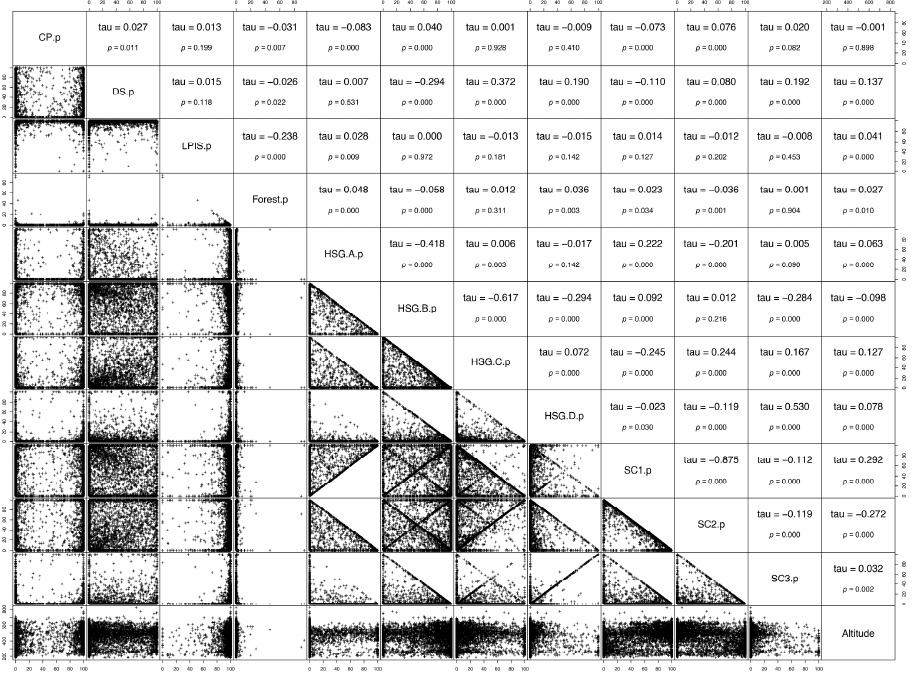
Figure 5. Scatterplot matrix of the full dataset representing the characteristics of EEAs by parameters with Kendall’s tau correlations above the diagonal.